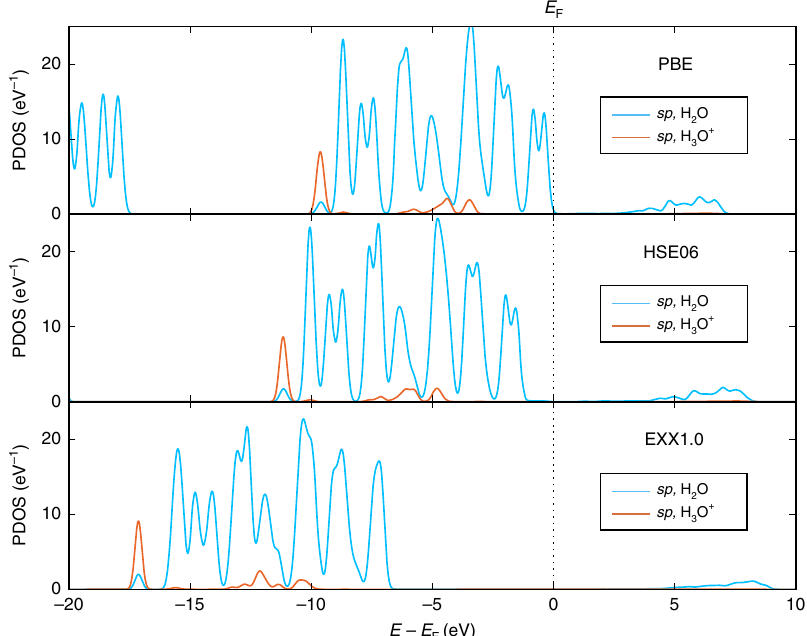
Fig. 3 Projected solvent and ion density of states for the Pt(111) | acidi fi ed water interface. The proton is solvated in the outer Helmholtz plane as shown in Fig. 1a and b. The geometry is optimized at the PBE-DFT level of theory. Three different methods are shown for the proton, from top to bottom: PBE, HSE06, and EXX1.0. The valence states (2 s , 2 p ) are projected for oxygen and the 1 s states are projected for hydrogen